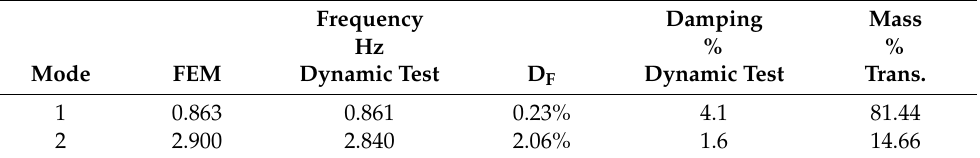
Table 2. Response spectrum parameters.